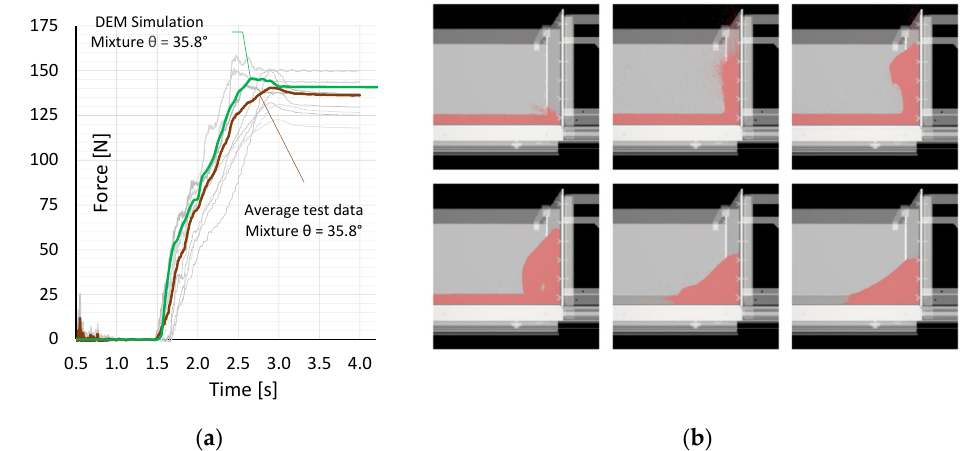
Figure 14. ( a ) Force–time history comparison of model test data with the results of the DEM simulation; ( b ) images from the DEM simulation showing the impact in 6 steps.